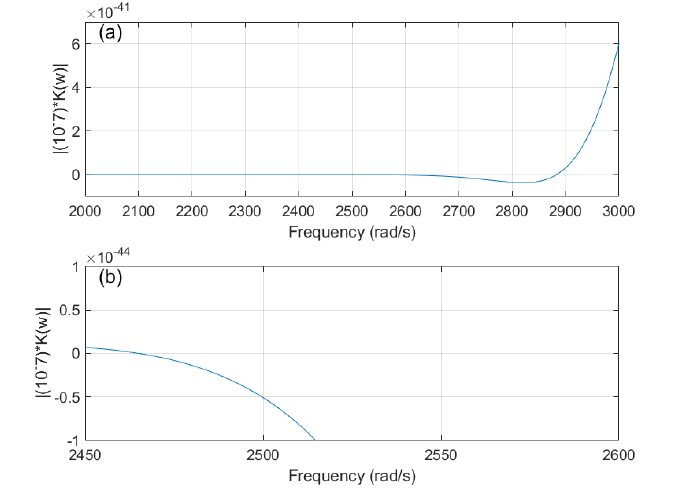
Figure 23. Dynamic Stiffness Matrix plot of Euler–Bernoulli Beams in Topology 1 with hinged ends using DSM; original configuration ( a ) a selected region of natural frequencies showing zero–crossing at the 10th natural frequency ( b ) a detailed section showing zero–crossing at the 9th natural frequency.